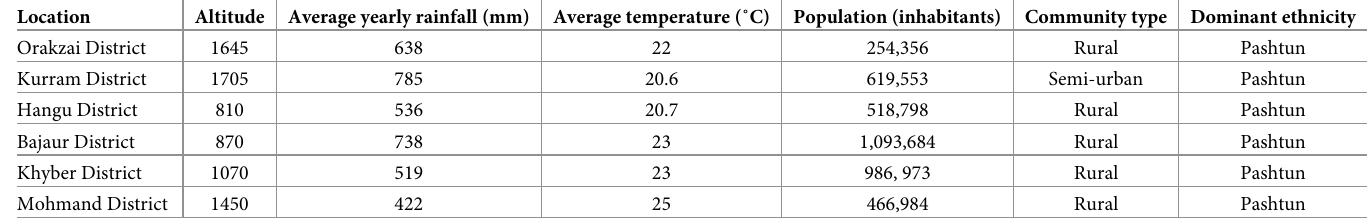
Table 1. Summary of climatic data for the six study sites in KPK, Pakistan. Data include altitude, average yearly rainfall, population, community type and dominant ethnicity in the region. The sites are endemic for both malarial species ( P . vivax and P . falciparum ).